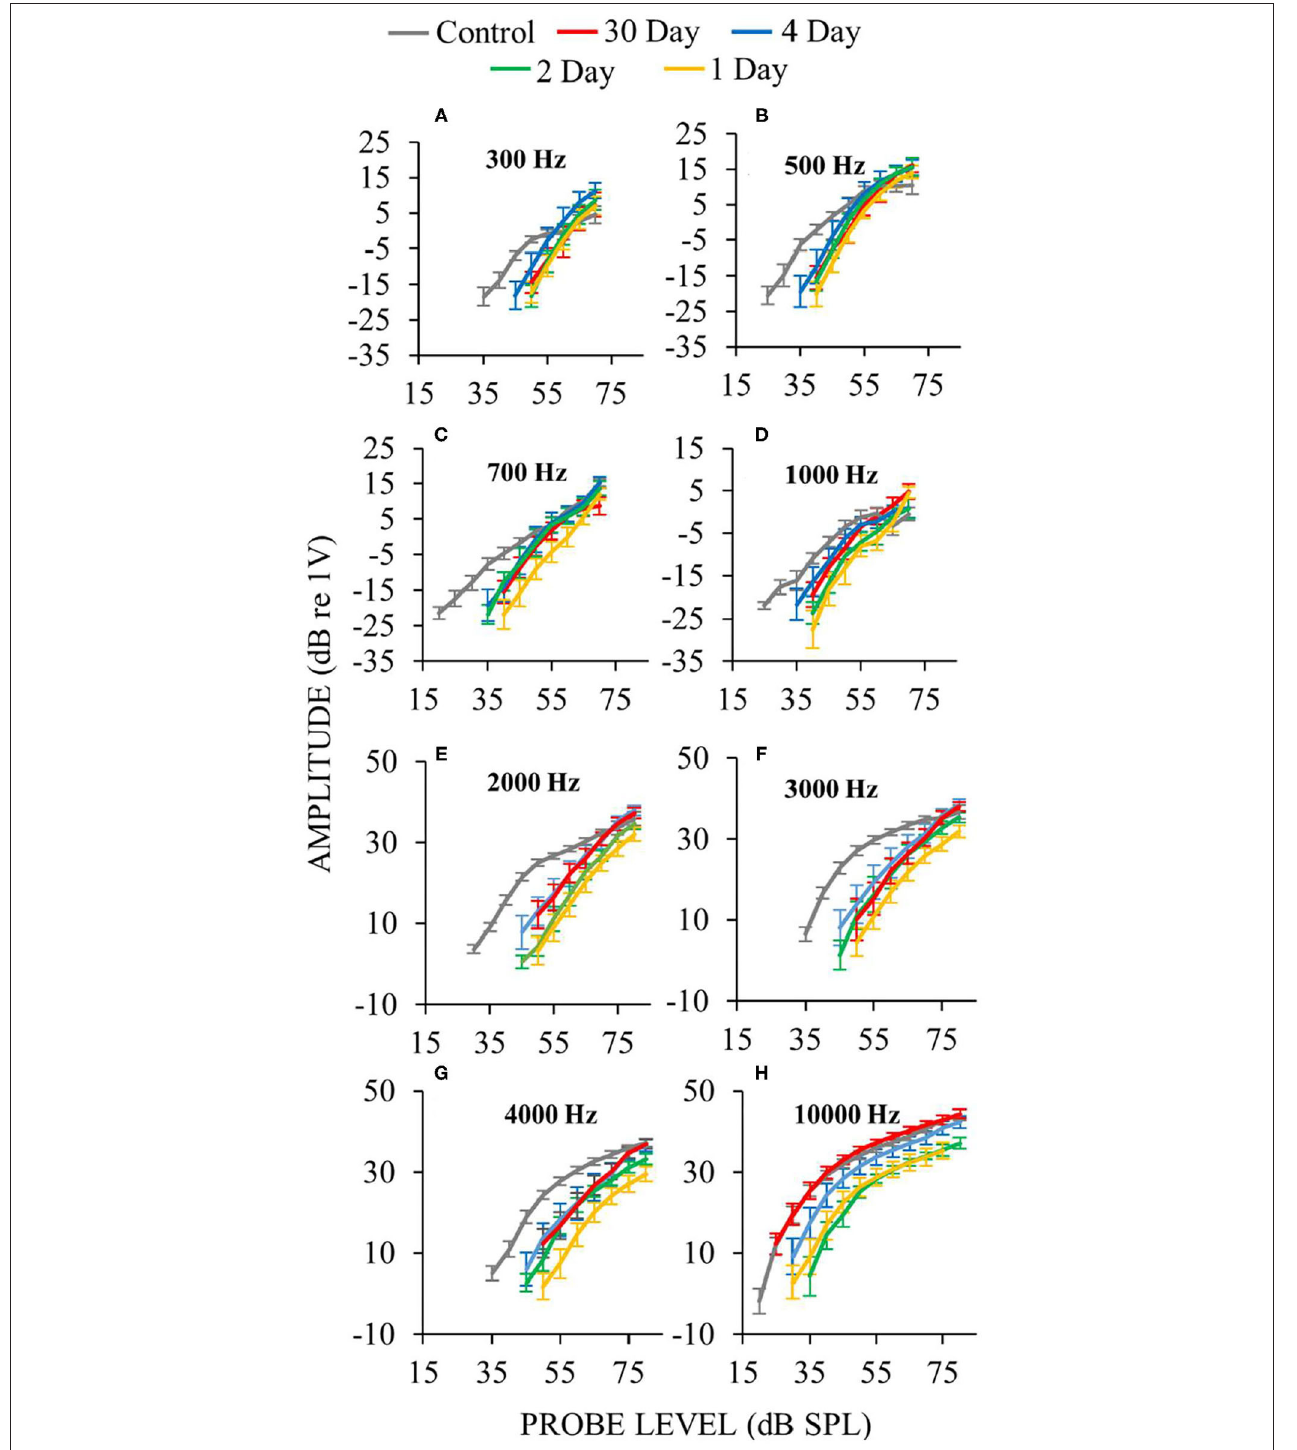
FIGURE 10 | Auditory-nerve response amplitudes vs. sound-level during the first few days following endolymphatic sac surgery. Low-frequency measurements were made with ANOWs at 300Hz (A) , 500Hz (B) , 700Hz (C) , 1,000Hz (D) , mid- and high- frequency measurements were made with CAPs at 2,000Hz (E) , 3,000Hz (F) , 4,000Hz (G) , and 10,000Hz (H) . Data from eight control animals that were either naïve or underwent a sham surgery. Error bars are one standard error of the mean. The number of ears used for ANOW measurements at 30, 4, 2, and 1 postoperative days are, respectively, 17, 10, 6, and 10. The number of ears used for CAP measurements at 30, 4, 2, and 1 postoperative days are respectively 14, 10, 6, and 10. Response recruitment can be seen at low frequencies during the earliest (1–4) postoperative days before endolymphatic hydrops has been detected, indicating that response recruitment can precede the development of histologically detectable endolymphatic